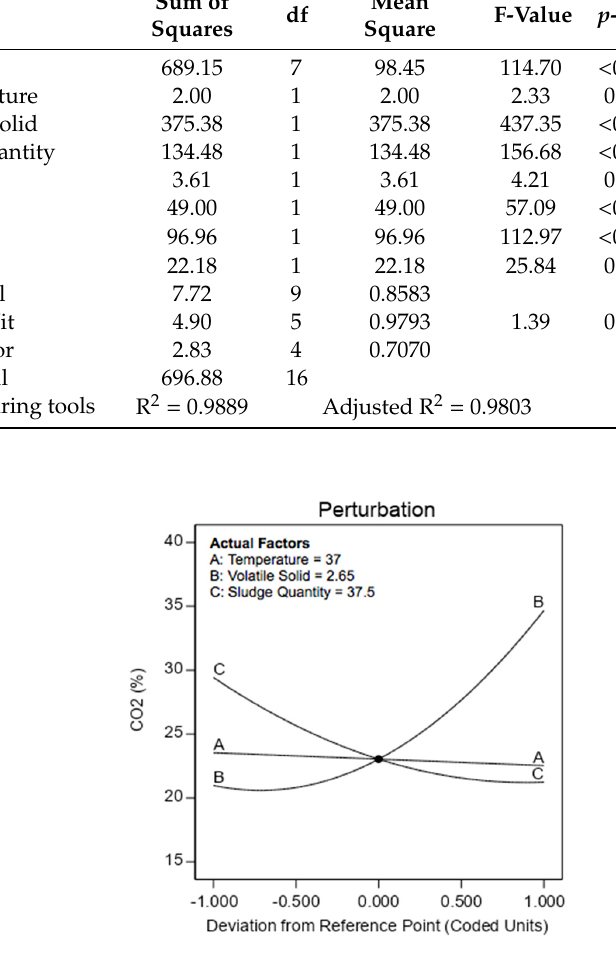
Figure 12. Perturbation plot showing the e ff ect of all factors on the CO 2 %.